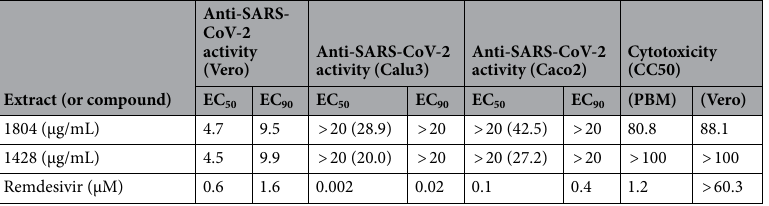
Table 4. The antiviral activity of 1804 and 1428 has been further confirmed by virus yield reduction assay using specific qRT-PCR for SARS-CoV-2 to measure the RNA copy number of the virus either 2 days post- treatment (for Vero cells) or 3 days post-treatment (for Calu-3 and Caco-2 cells) in treated-infected cells in a dose response manner. Numbers in parentheses indicate percent inhibition at the highest concentration tested. Cytotoxicity assays measuring the cell proliferation in PBM and Vero cells were performed in parallel to the antiviral assays. Accompanying plots can be found in Fig. 3.